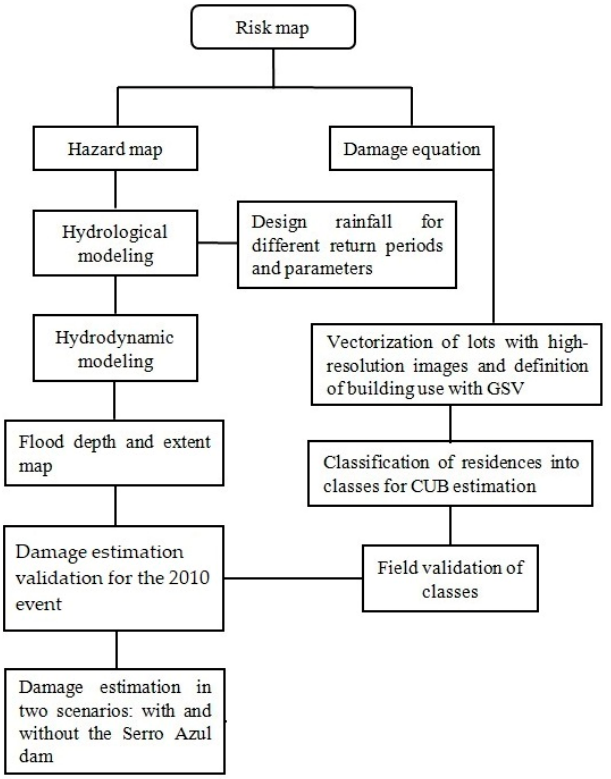
Figure 2. Flowchart of the methods used in the study (GSV: Google Street View; CUB: Basic unit of cost of construction).